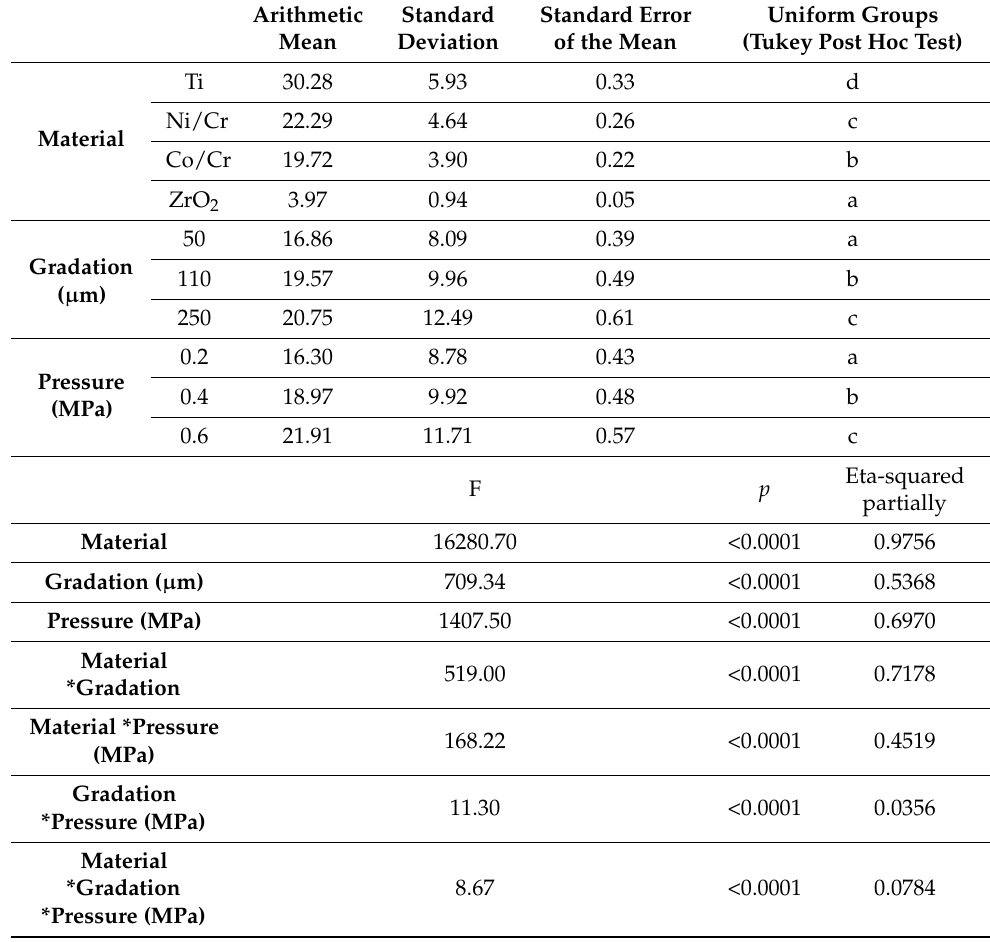
Table 3. Descriptive statistics of the amount of embedded abrasive particles (SiC) with regard to the studied parameters, as well as a table of analysis of variance.